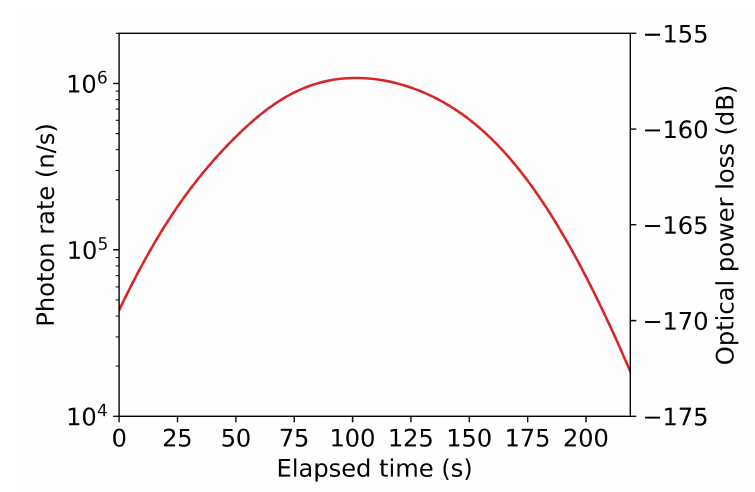
Figure 5. Excess photon rate at the QKD ground station and optical power loss over time (represented in seconds elapsed since the satellite came into view of the ground station) achieved for a 1 kW laser launched via a 30 cm telescope 1000 km from the ground station. (The satellite moves out of view of the laser terminal around 220 s assuming a lower elevation limit of